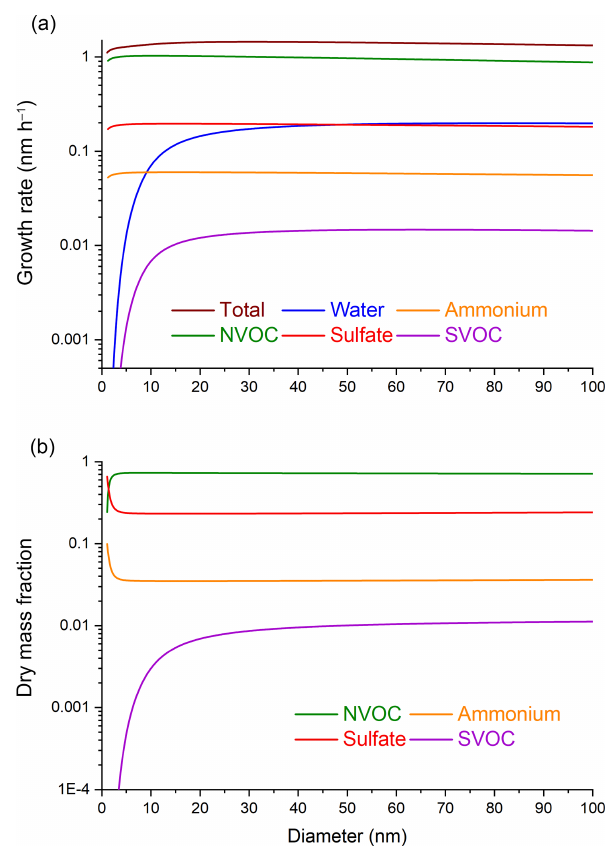
Figure 1. Particle diameter dependence of (a) growth rates and (b) dry mass fractions of chemical species under the conditions where the gas-phase mixing ratios are constant and growth occurs by partitioning alone.